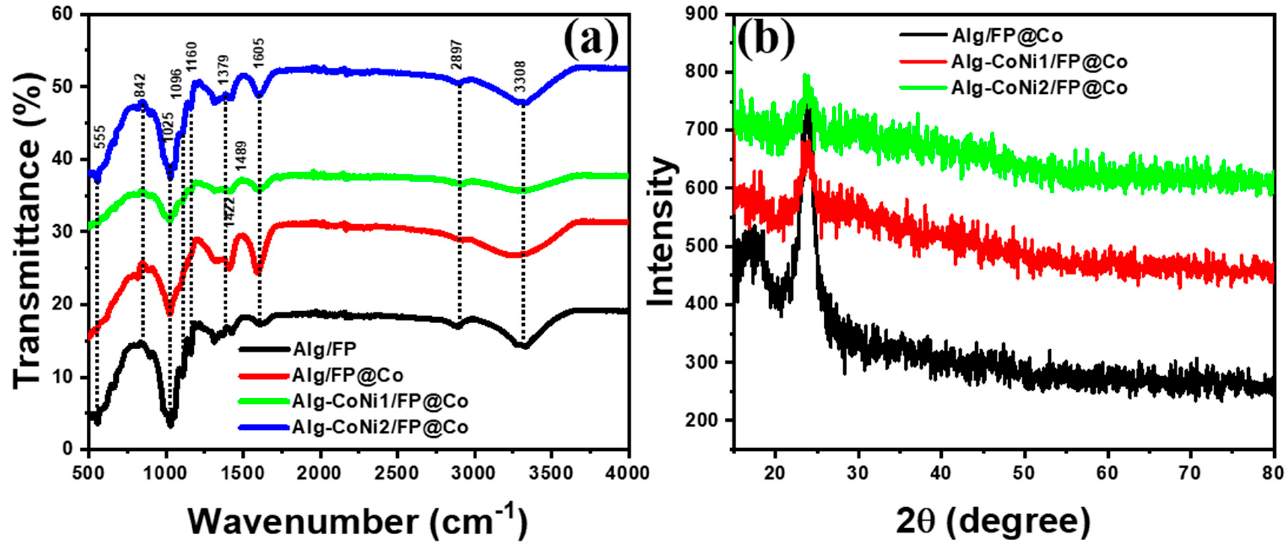
Figure 2. FTIR ( a ) and XRD ( b ) of Alg/FP, Alg-CoNi1/FP@Co, and Alg-CoNi2/FP@Co NPs.